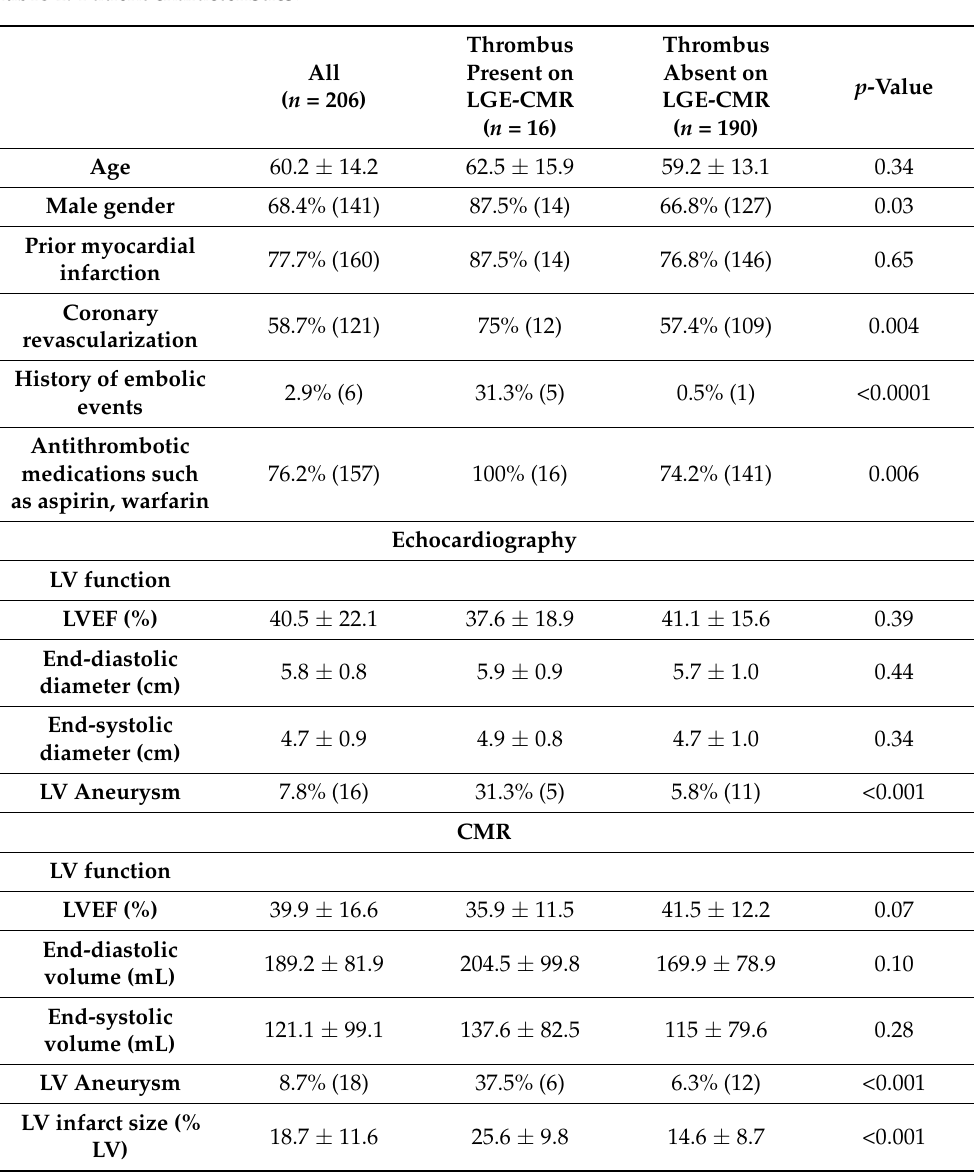
Table 1. Patient